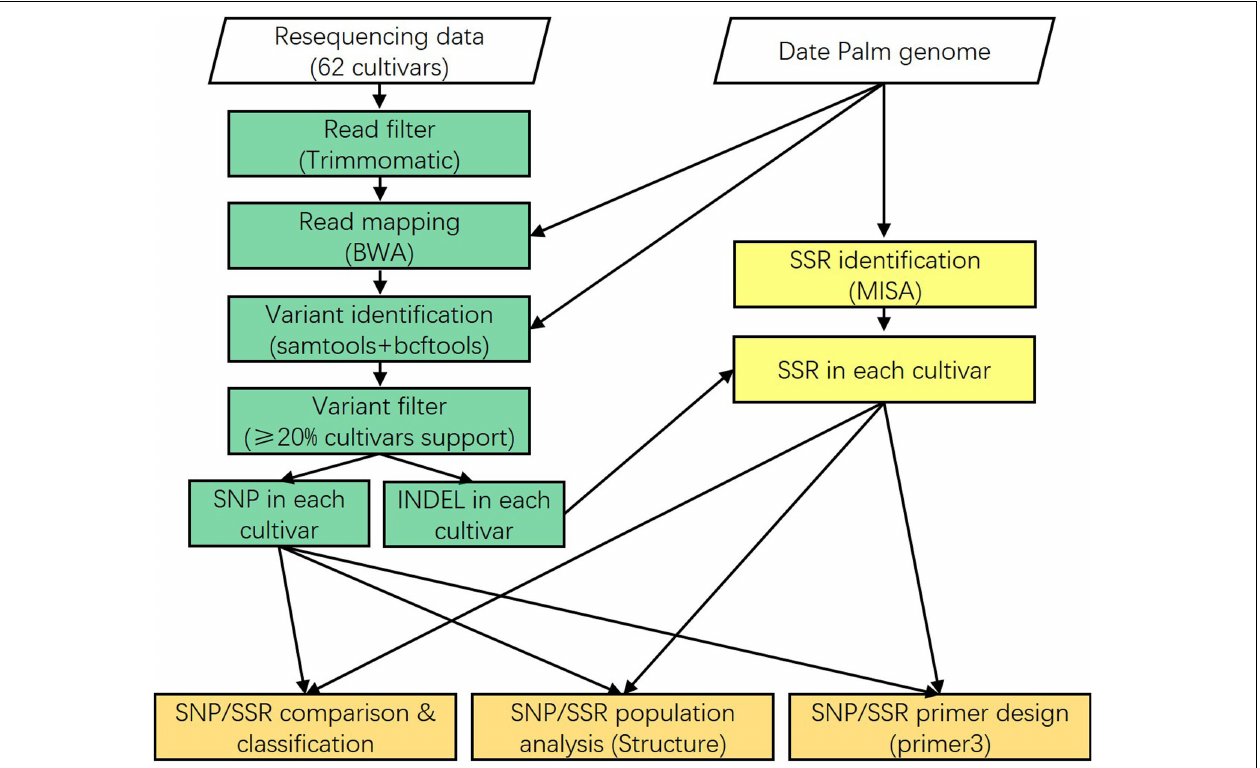
FIGURE 1 | Single nucleotide polymorphisms (SNPs) and short sequence repeats (SSRs) identification pipeline. The 62 date palm cultivars were used to detect SNPs and SSRs. Classification, population structure, and primer design were performed for these SNPs and SSRs.